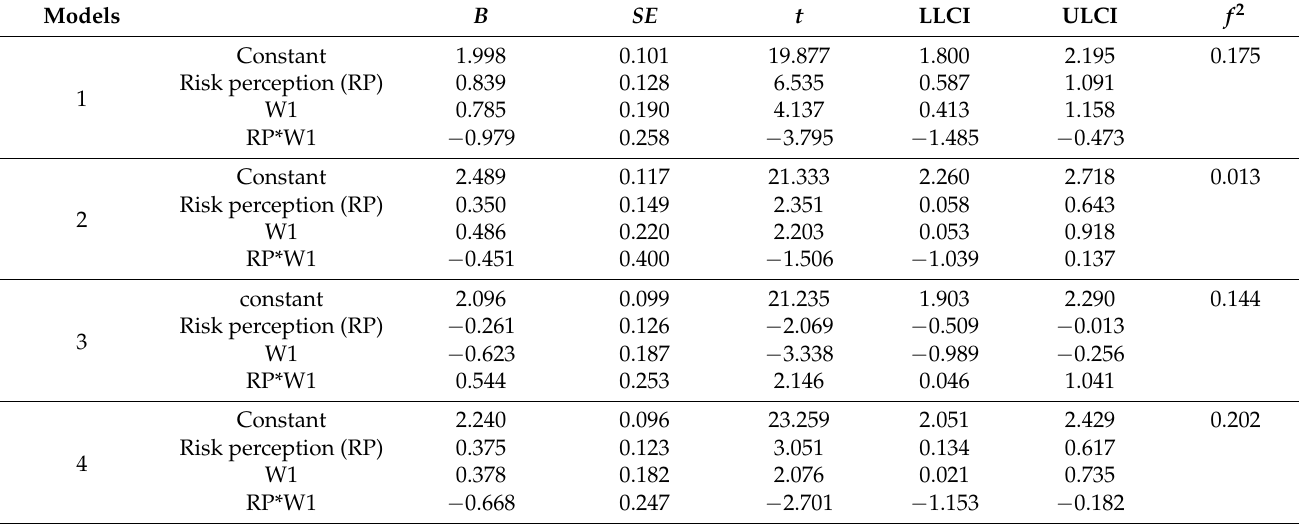
Table 3. Moderation parameters for gender in the link between COVID-19 risk perception and coping